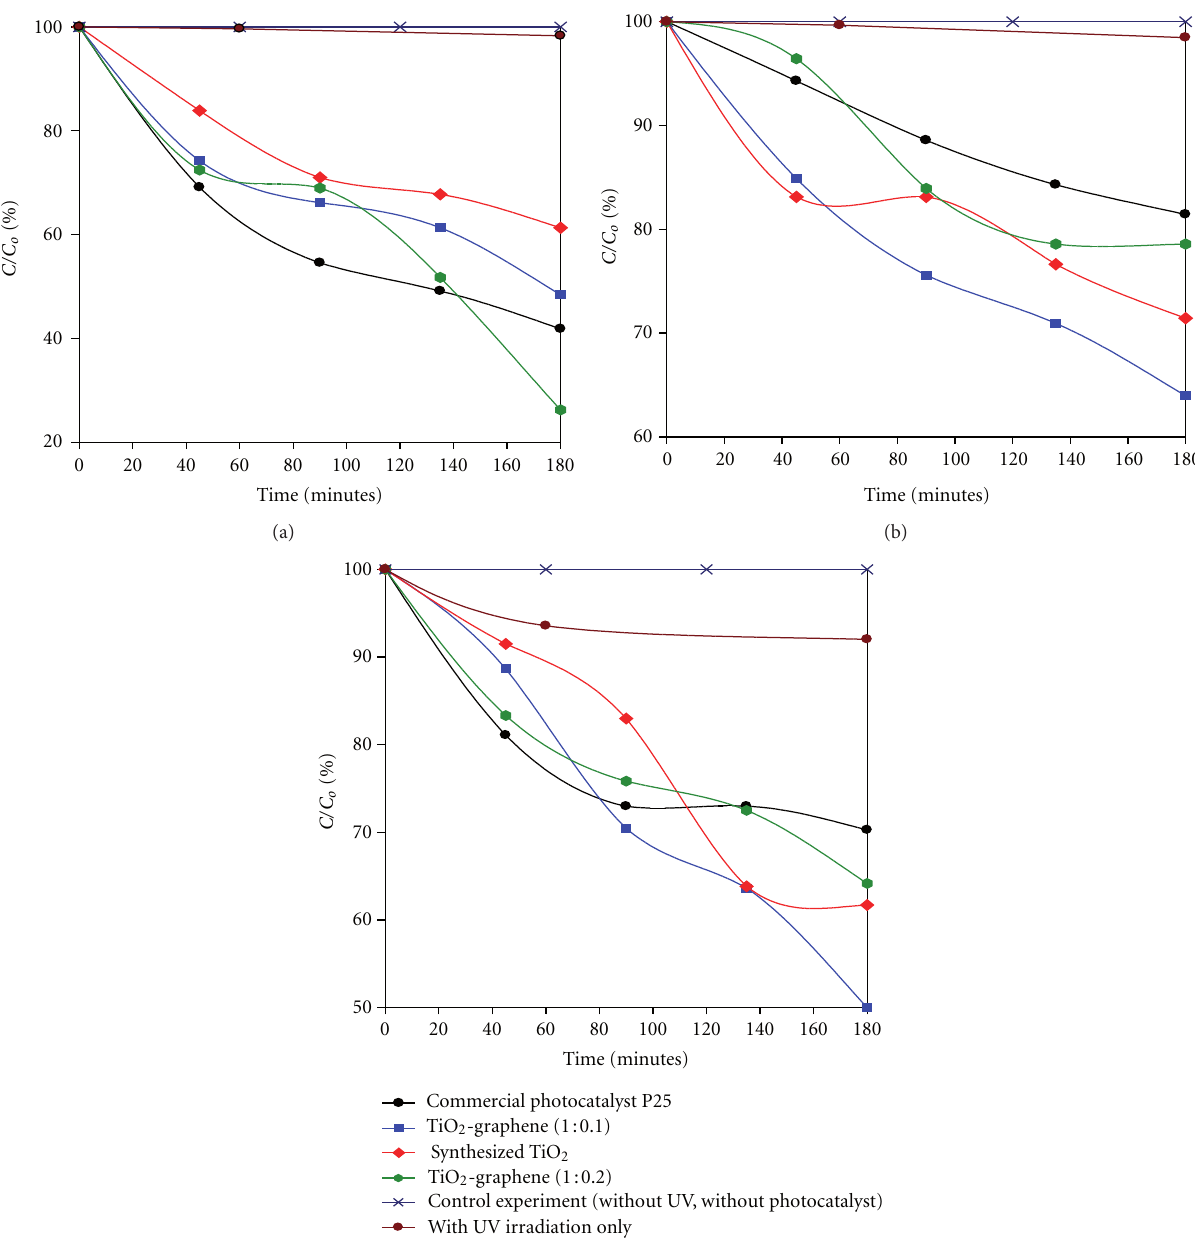
refers to the 𝐶𝐶𝐶𝐶𝐶 0